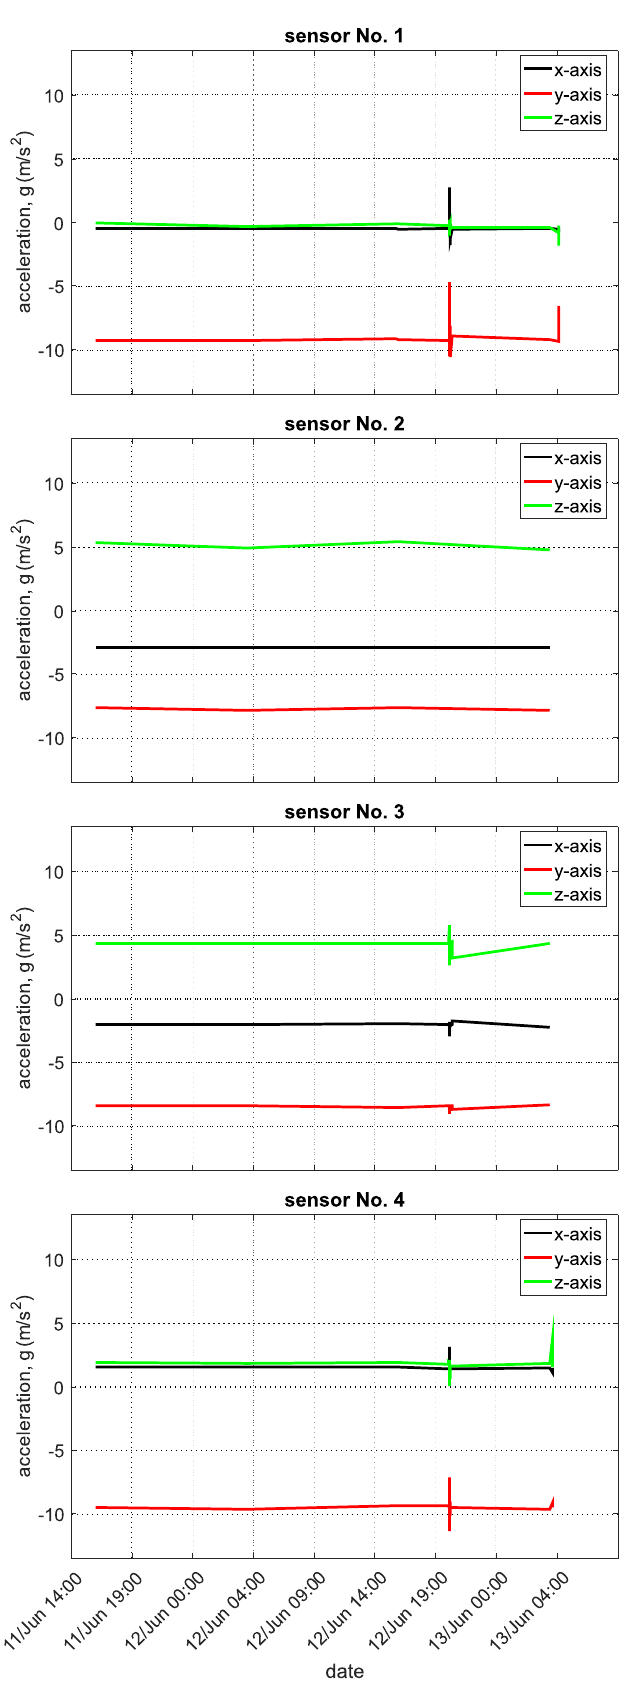
Figure 20. Data from accelerometric wireless sensor nodes installed at